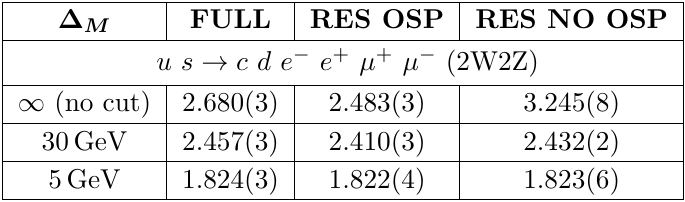
c d e (cid:0) e + (cid:22) (cid:0) (cid:22) + , for M M Z < (cid:1) M ( ‘ = e; (cid:22) ). ‘ + ‘ (cid:0) (cid:0) ! j j > 20 GeV ; (cid:17) j < 5 : 5 ; M jj > 600 GeV ; (cid:1) (cid:17) jj > 3 : 6 ; M 4 ‘ > t j j j j